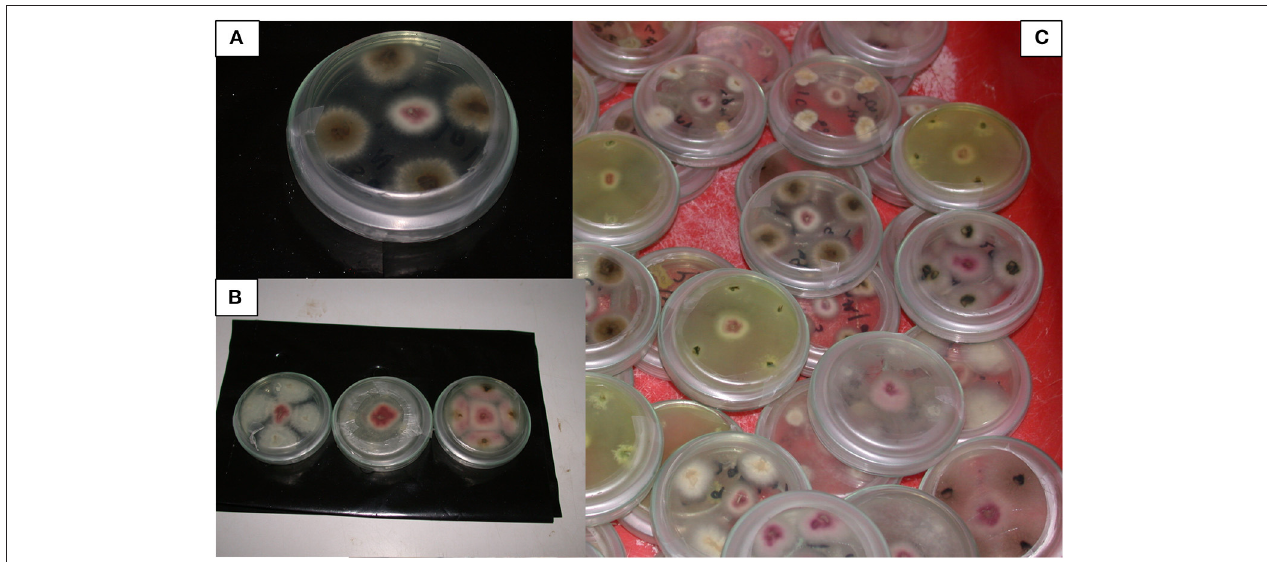
FIGURE 8 | Fusarium spp. and other endophytic microbes isolated from potted tissue culture banana plants under independent or combined inoculation with Fusarium oxysporum V5w2 and Radopholus similis , and grown in either sterile soil or non-sterile soil supplied with complete nutrient solution. (A) F. oxysporum V5w2 can be seen with pinkish-white mycelia at the central spot surrounded by an endophytic fungus with brownish mycelia isolated from the banana roots in a Petri dish containing potato dextrose agar (PDA). (B) F. oxysporum V5w2 at the central spot surrounded by Fusarium spp. isolated from non-inoculated plants (third right) . (C) Diversity of endophytic microbes isolated from roots of tissue culture banana plants especially those grown in non-sterile